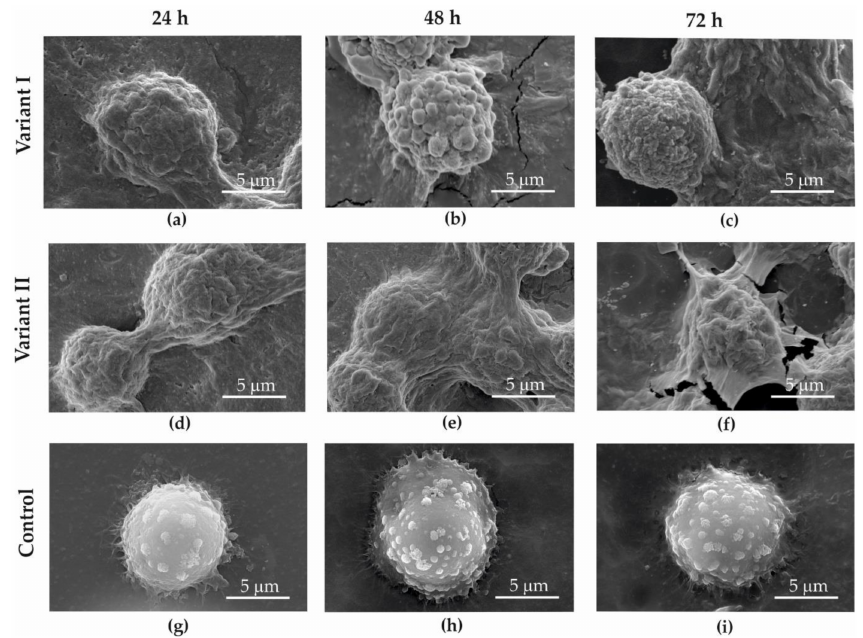
Figure 8. SEM image of SW-954 cancer cells obtained for variant I ( a – c ); variant II ( d – f ); and control ( g – i ); after 24 ( a , d , g ), 48 ( b , e , h ), and 72 h ( c , f , i ).